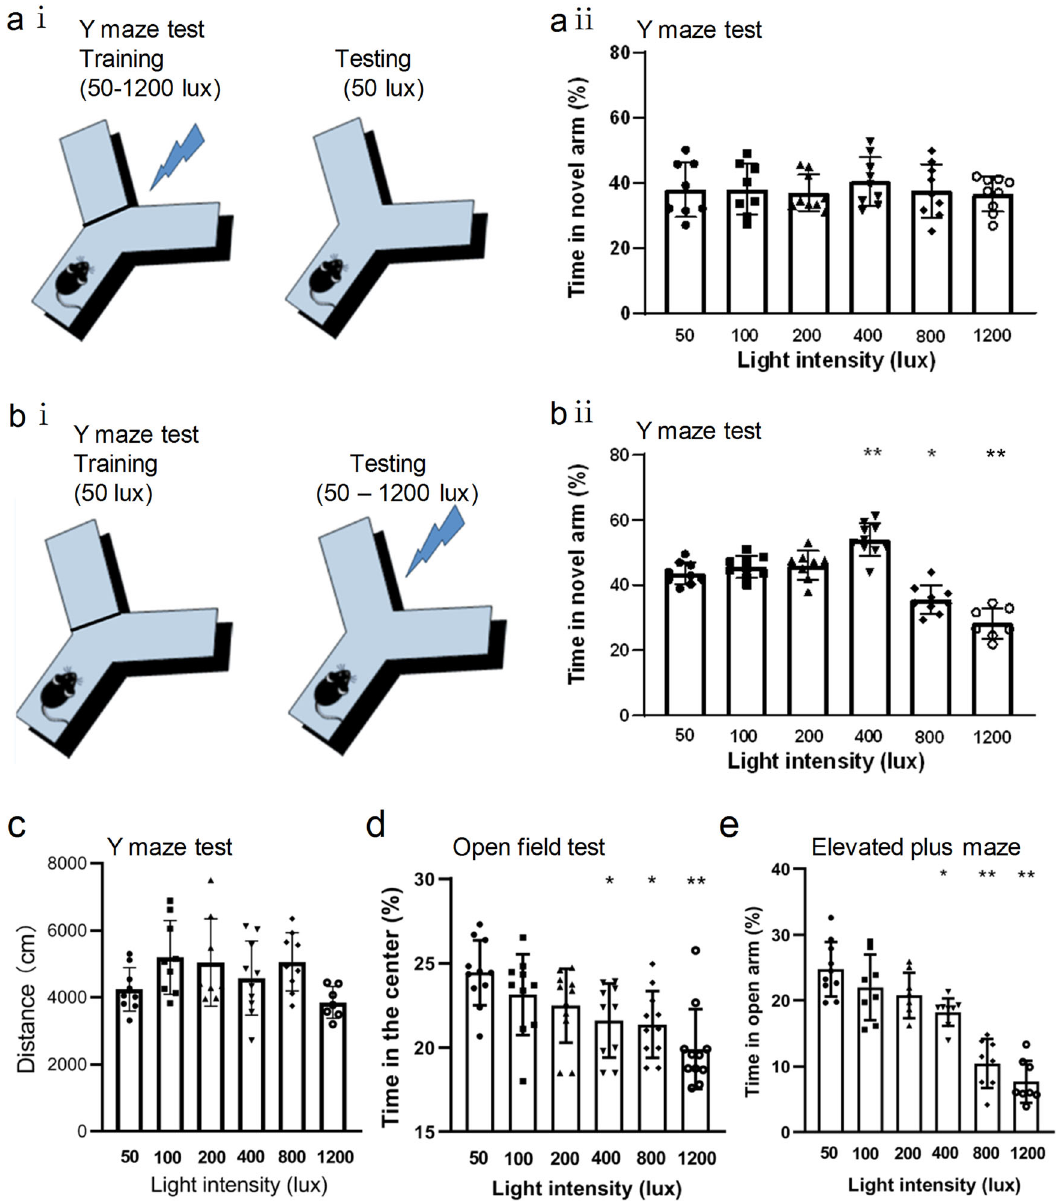
Fig. 1 Effects of light exposure on spatial memory task performance and anxiety level in animal behavioral tests. a (i) The schematic diagram of the Y-Maze test. Different intensities (50, 100, 200, 400, 800, 1200 lux) of white light were applied in the training period, and 50 lux light was applied during the testing period. a (ii) Percentage of the time that mice spent in the novel arm during the testing period in each group (non-parametric Kruskal-Wallis H Test, n = 8 – 9/group). b (i) In a separate study, different groups of mice received 50 lux light exposure in the training period, but were exposed to different intensities of light (50 – 1200 lux) during the testing period. b (ii) Percentage of the time that mice spent in the novel arm during the testing period ( n = 7 – 10/group). c Distance of mice traveled in the Y maze test under different light intensity during the testing period (non-parametric Kruskal-Wallis H Test) . d Percentage of the time that mice spent in the central area of the open fi eld under the different intensities of light exposure (non-parametric Kruskal-Wallis H Test, n = 7 – 10/group). e Percentage of the time that mice stayed in the open arm of the elevated plus-maze under different light exposures ( n = 8 – 10/group). Data are mean ± SD. * P < 0.05, ** P < 0.01 vs. 50 lux group, one-way ANOVA with Dunnett-t multiple comparison test unless otherwise